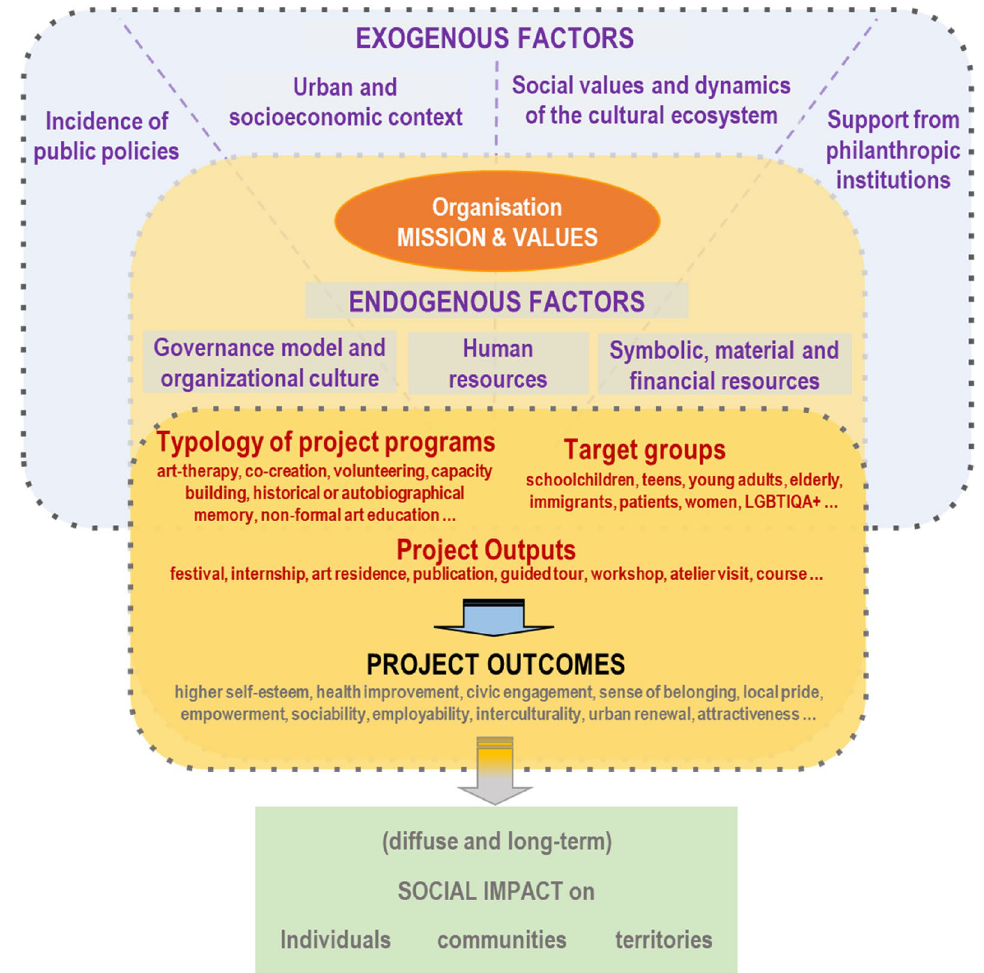
Fig. 1 Exogenous and endogenous factors affecting the social outcomes and impacts of cultural